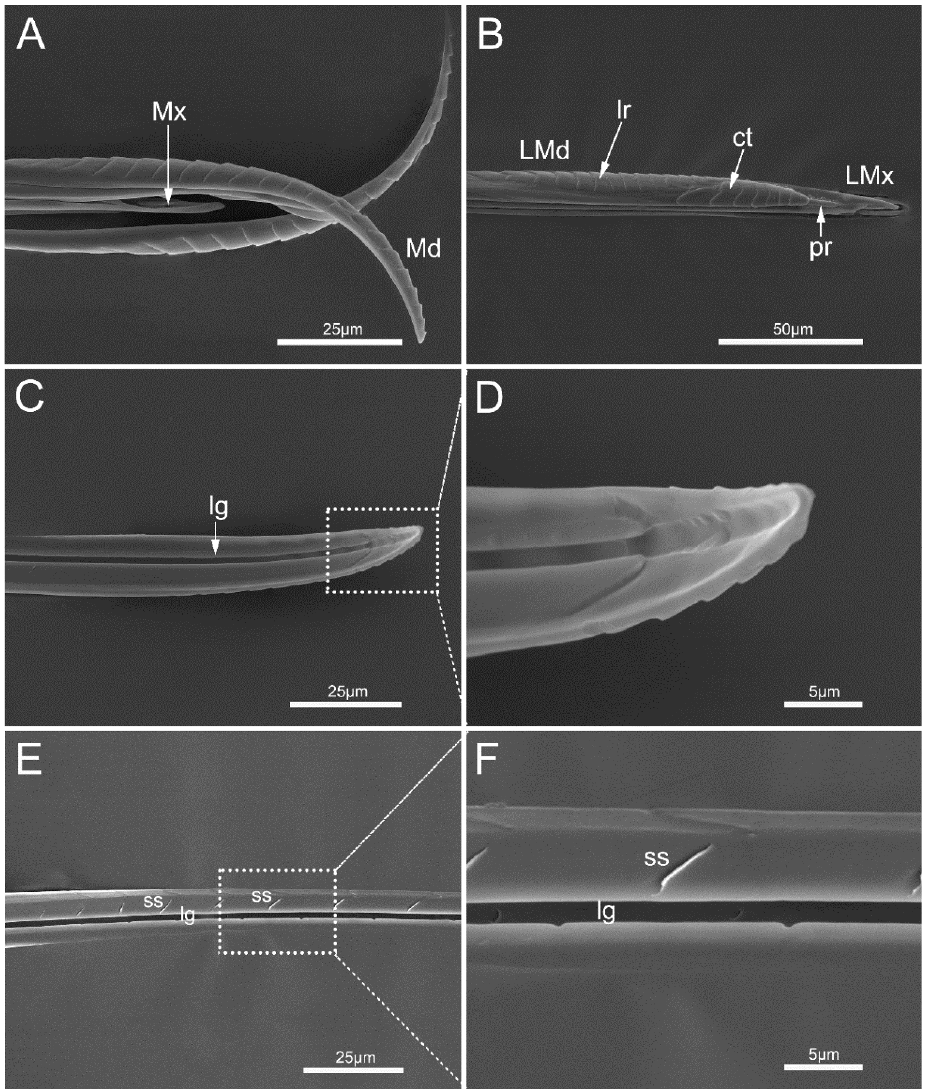
Figure 7. Mandibular stylets of Mezira yunnana . ( A ) Mandibular stylets (Md) and maxillary stylets (Mx); ( B ) left mandibular stylet (LMd) and left maxillary stylet (LMx) with an external longitudinal process (pr); ( C ) interior view of mandibular stylet showing longitudinal groove (lg); ( D ) enlarged view of the inner surface of mandibular apex; ( E ) interior view of mandibular stylet showing longitudinal groove and small spikes (ss); ( F ) enlarged view of the small spikes; ct, central teeth; lr, lateral ridges.